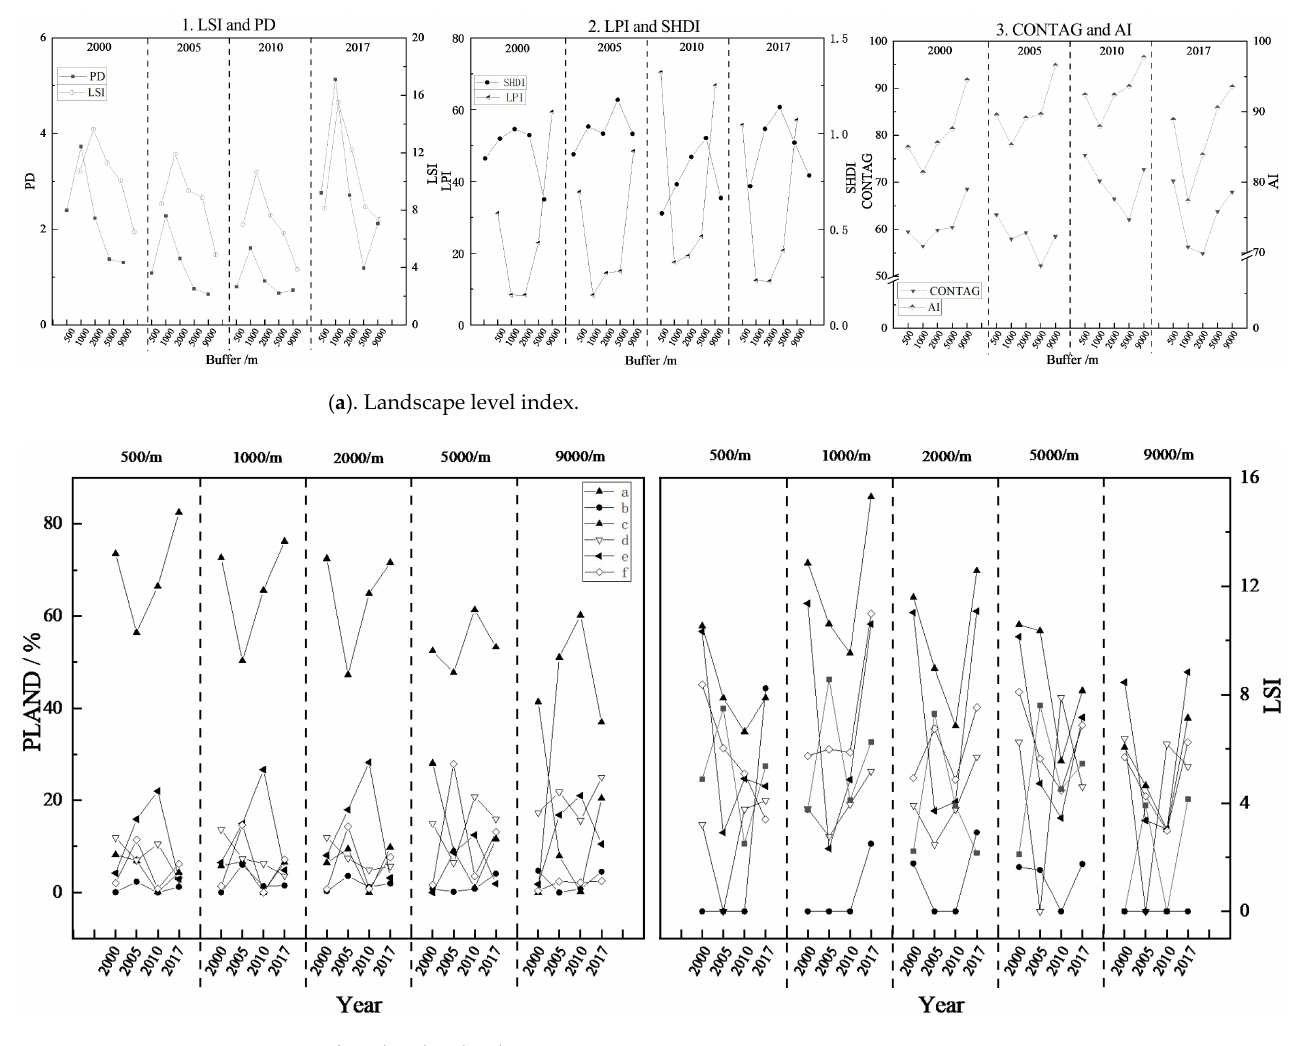
Figure 5. Spatial evolution of rocky desertification patches with different buffers in the tourist areas from 2000 to 2017. Note: a—non-rocky desertification; b—potential rocky desertification; c—light rocky desertification; d—medium rocky desertification; e—severe rocky desertification; f—extremely severe rocky desertification.